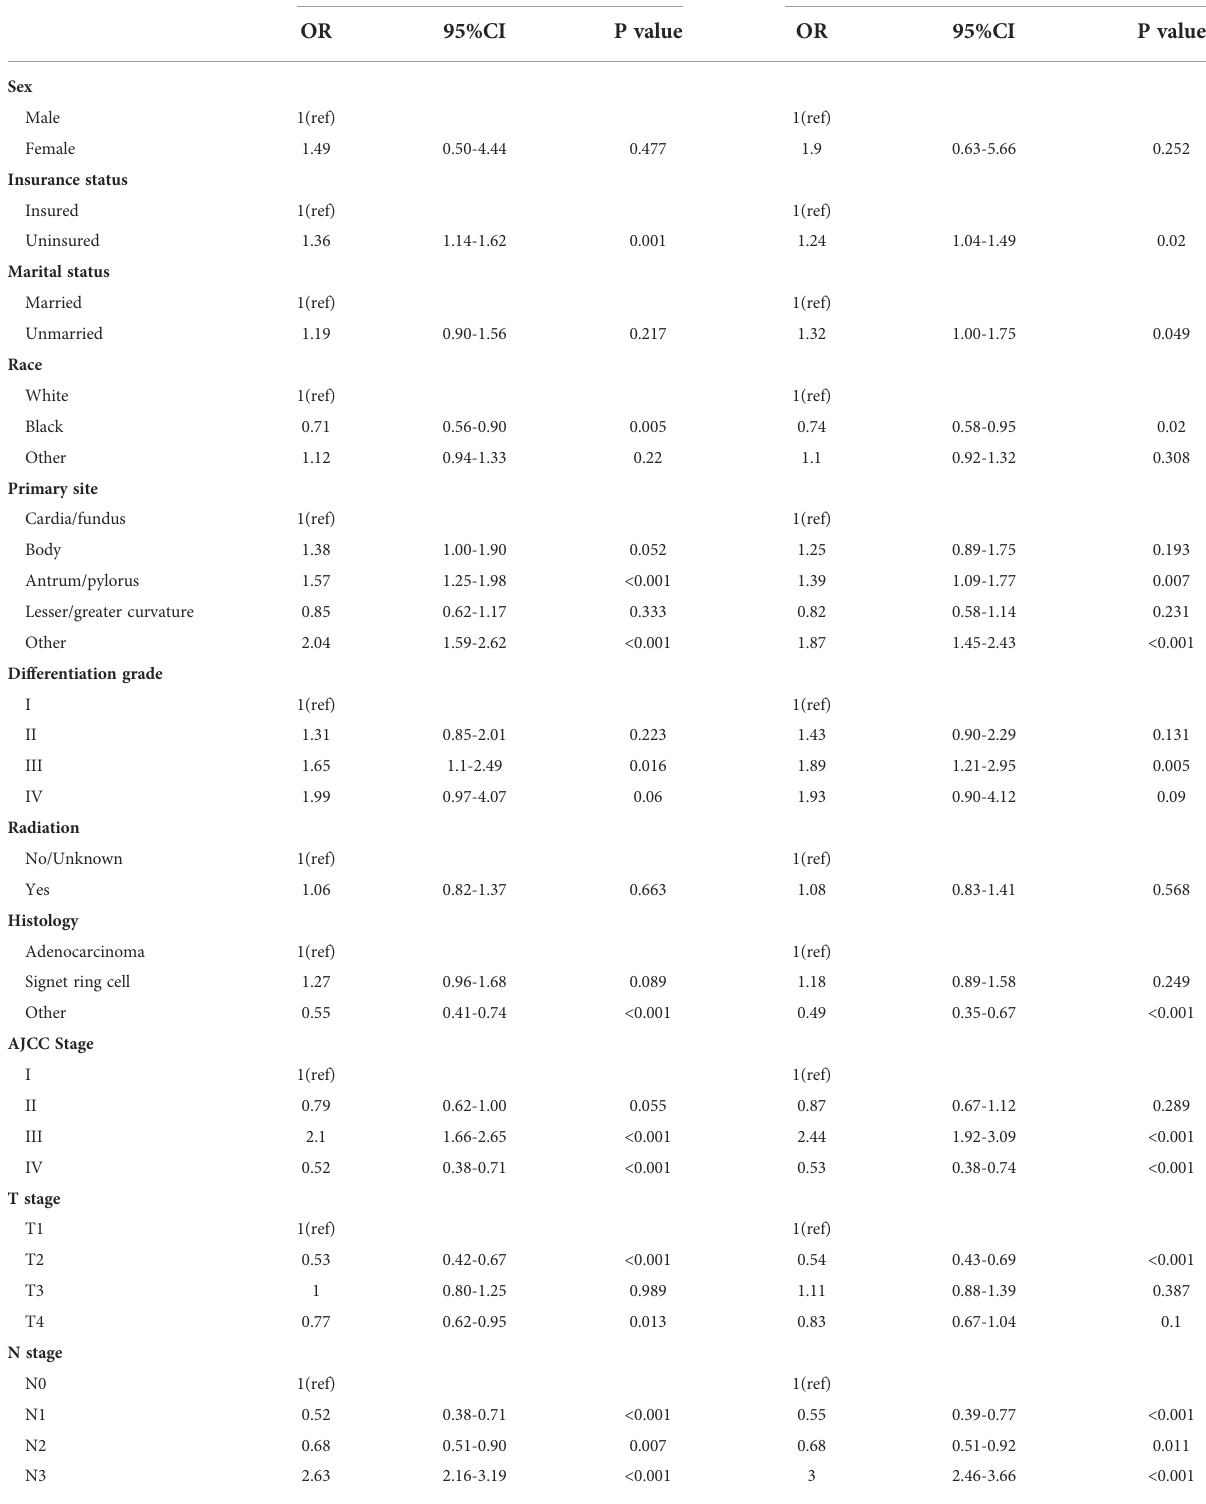
TABLE 3 Univariate logistic regression for analyzing the prognostic factors for early